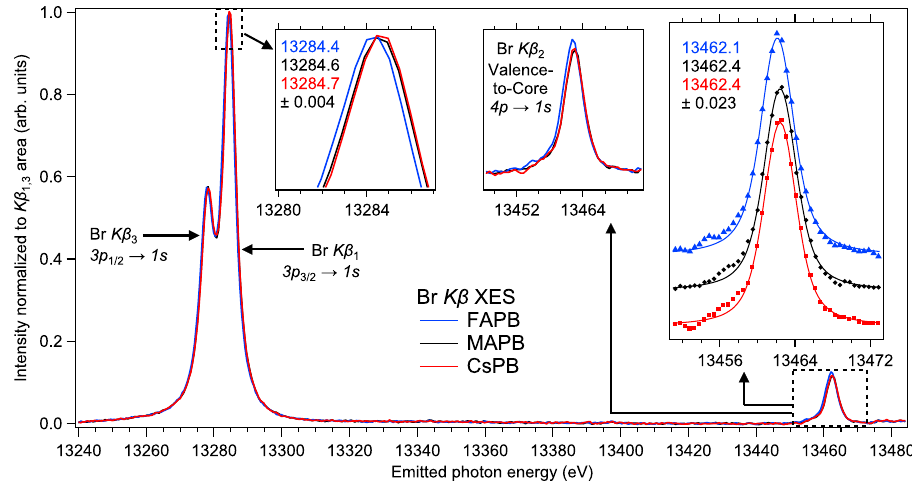
Fig. 4 X-ray emission spectra of FAPB, MAPB and CsPB. The K β 1 and K β 2 /VtC peaks are fi tted with Voigt peaks; the fi tted values and uncertainties are displayed in the insets. The Voigt peak fi t of the main VtC emission line is intended to extract the energy position of the peak maximum. The center inset shows VtC intensities associated with normalized K β 1